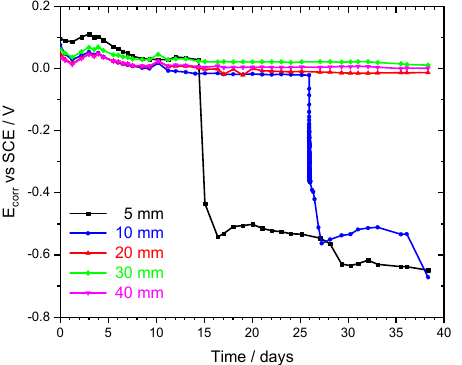
Figure 8. OCP evolution of Fe electrodes embedded in a mortar sample exposed to 1 M H 2 SO 4 .